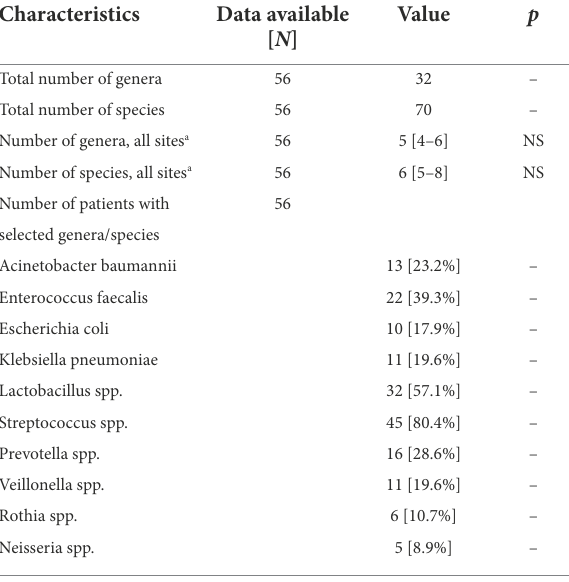
TABLE 2 Baseline qualitative microbiological characteristics of study